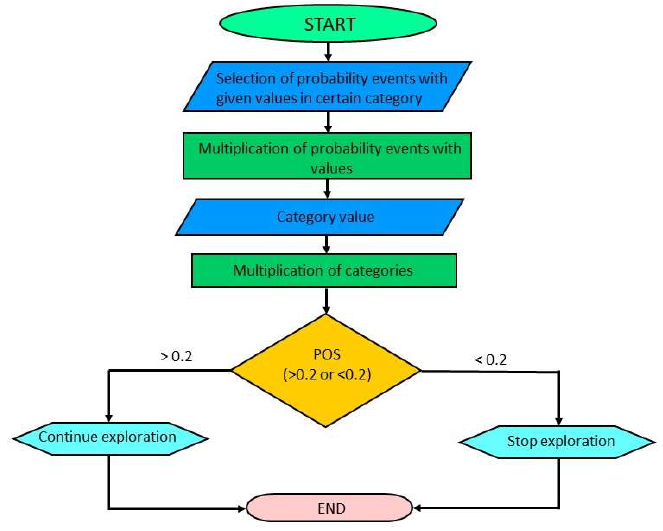
Figure 2. PoS algorithm of Režić & Varenina [7].